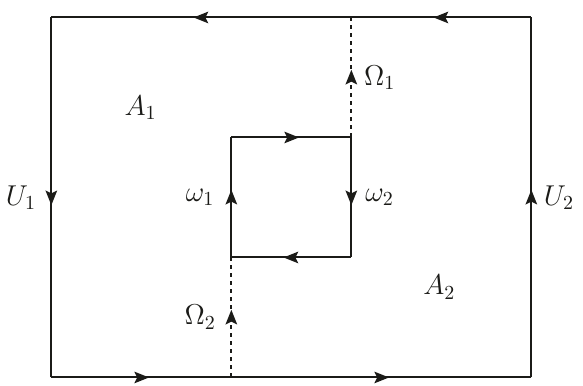
Figure 16 . The K-functional for a rectangle with a hole is obtained by gluing the two regions A 1 and A 2 . From this, the K-functional for the punctured torus is obtained similarly to what we did in (cid:12)gure 15. Integrating out the link variables surrounding the puncture, we obtain the partition function for the 2D U( N ) gauge theory on a punctured